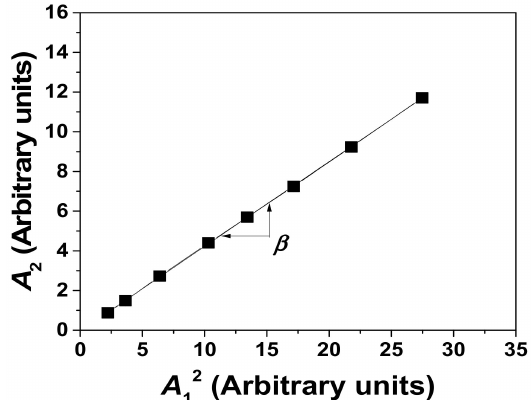
Figure 10. The relationship between A 2 and A 2 with various input signal amplitudes, showing a good 1 linear relationship. The slope of this linear relationship is the nonlinearity parameter ( β